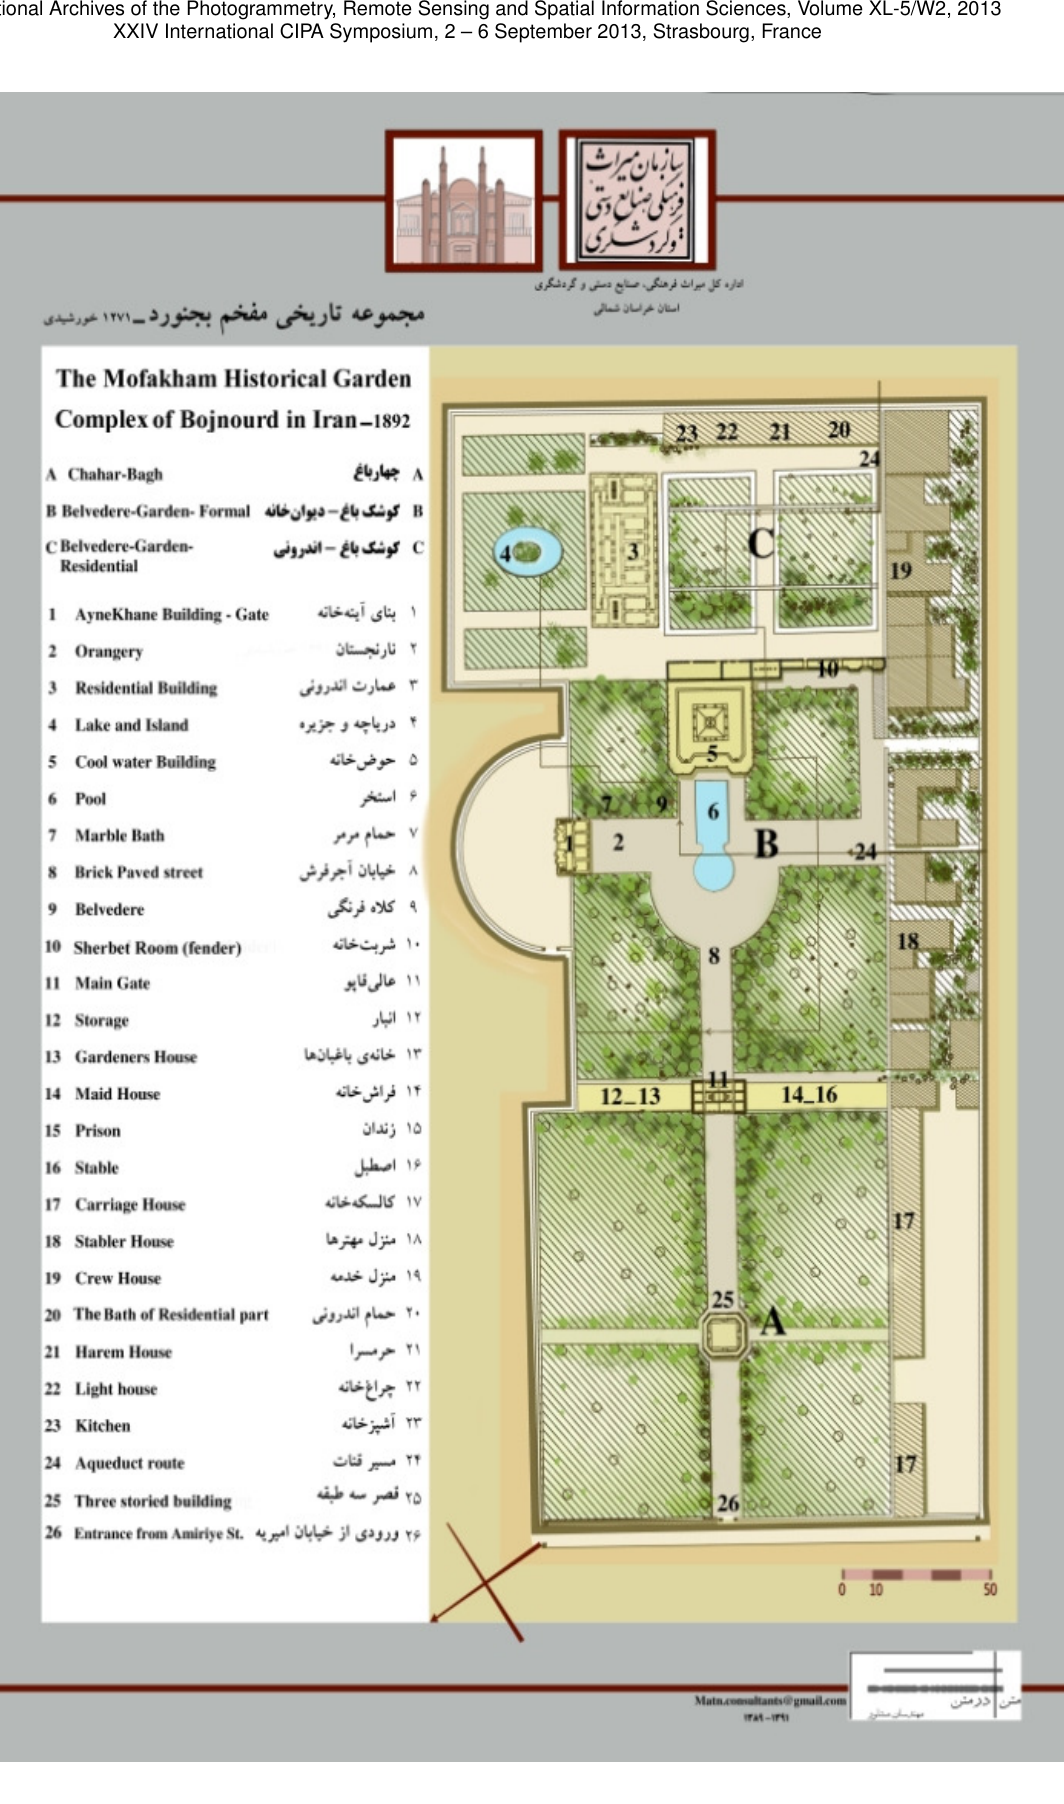
Figure 2: Components of Mofakham complex